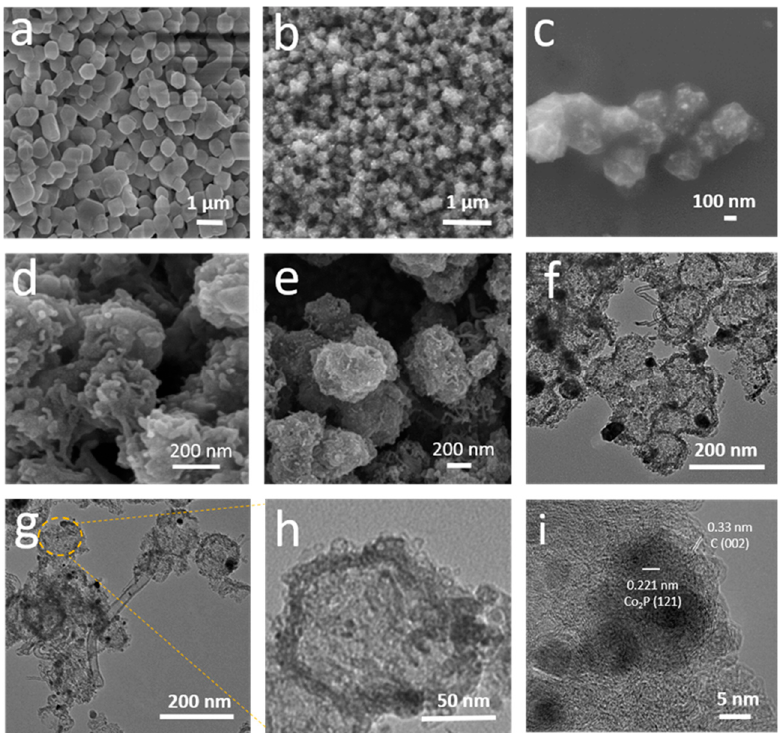
Figure 1. ( a – e ) SEM images of ( a ) ZIF-67; ( b , c ) Co-NC with high and low magnification, respectively; ( d ) Co-CNTs; ( e ) P-Co-CNTs; ( f – h ) TEM images of Co-CNTs and P-Co-CNTs, respectively; ( i ) HR- TEM image of P-Co-CNTs.